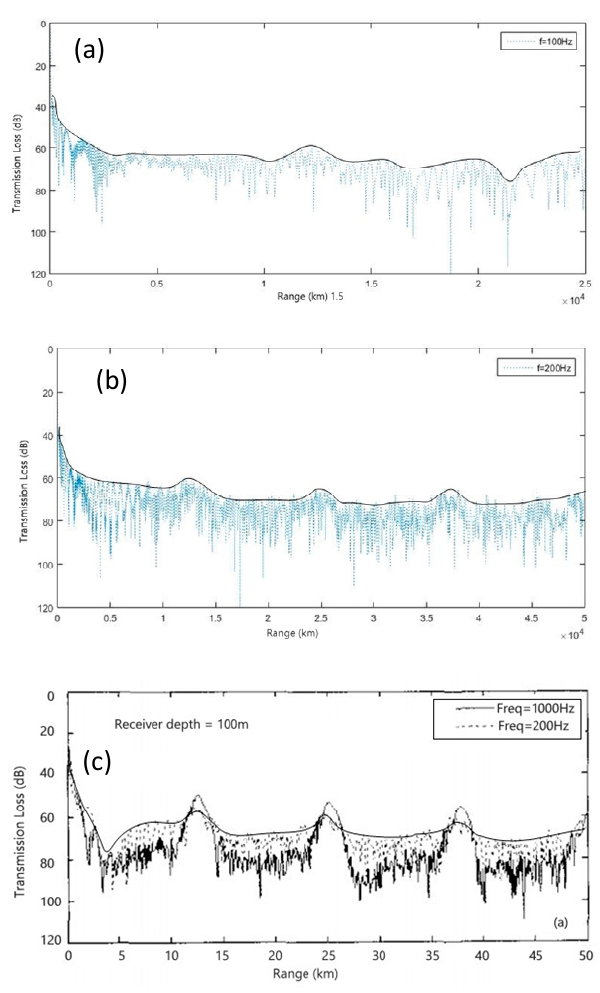
Figure 18. Sound transmission loss at different frequencies, ( a ) f = 100 Hz, 100 m depth (RAM PE Model), ( b ) f = 200 Hz, 100 m depth (RAM PE Model), ( c ) f = 200 Hz, 1000 Hz, depth 100 m (MMPE model).